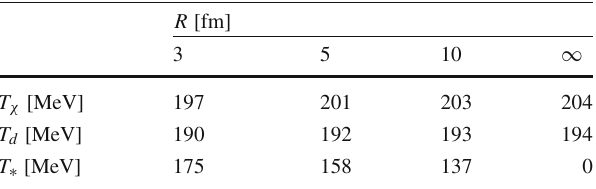
the critical temperatures T χ and T d for different radii of the system. We also display the temperature T ∗ below which the drop’s pressure P would become negative for the standard prescriptionof P v ac .Below T ∗ theseresultswouldbeunphys- ical if that P v ac is adopted. If another choice of P v ac is used the curves in Fig. 1 would shift upwards or downwards and a better coincidence of the model curves with lattice results could be achieved for the bulk case. From Tables 1, 2, 3 and 4 we see that (except for the cases U L and U F 2 with R = 3 fm) T ∗ is always below T χ . Since we are interested in the physics around the critical temperature (relevant for heavy ion collisions and the early universe) we will not show our results for T < T ∗ . We emphasize that the values of T χ and T d are independent of the choice of P v ac . In Table 1, we show our results for the polynomial Polyakov loop potential. The chiral critical temperature T χ has a significant dependence on the system size; it varies from 186 MeV to 177 MeV as the radius shrinks from infinity to 3 fm.ThiseffectisalsoapparentintheleftpanelofFig.2where weseethatthepeaksof ∂ (cid:4)¯ uu (cid:5) /∂ T movetowardssmallertem- peratures as the radius reduces. As seen in the right panel of Fig. 2, ∂ l /∂ T is less sensitive to finite size effects. Thus,